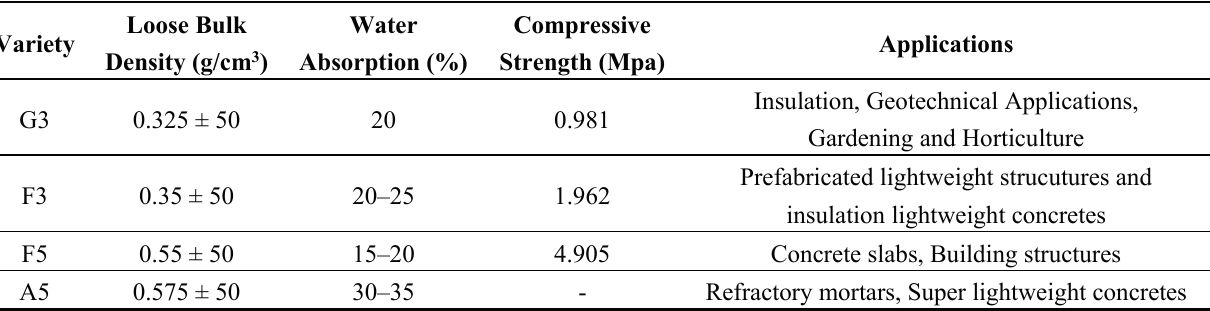
Table 4. Varieties of Arlita ® , features and